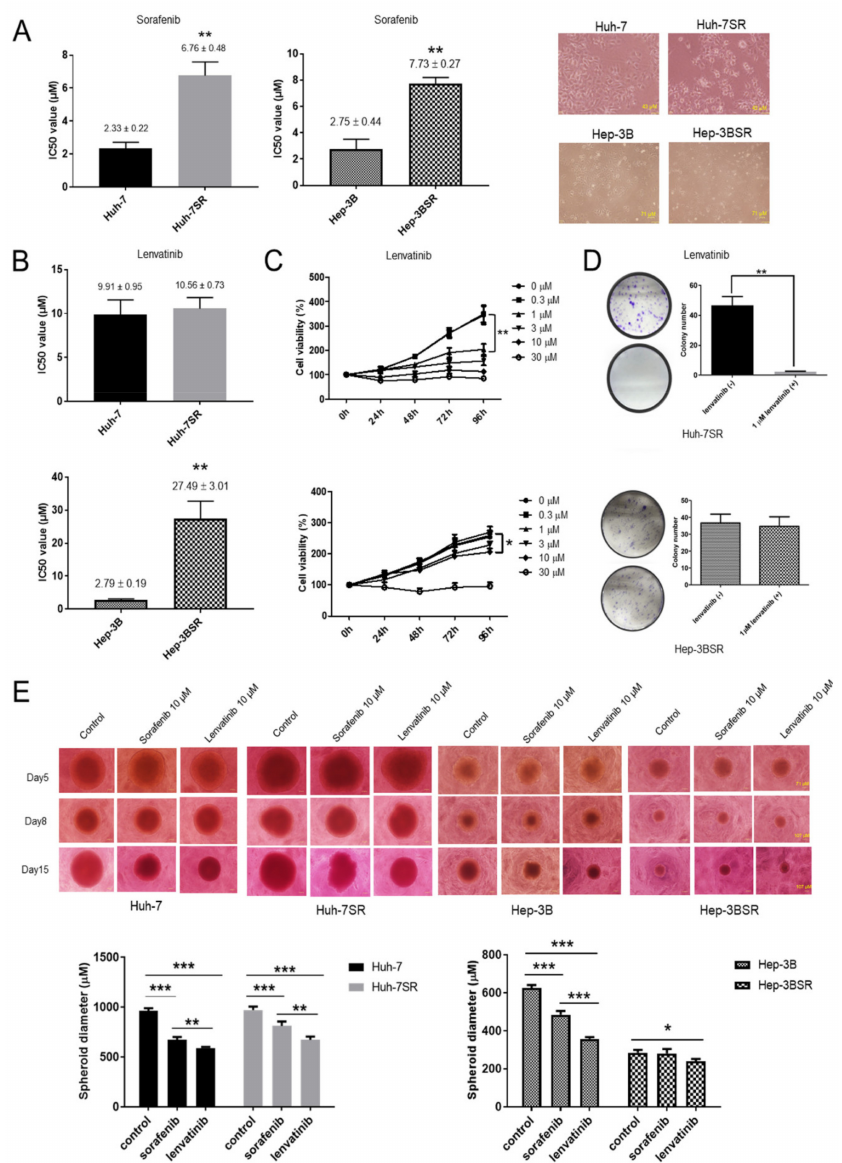
Figure 1. Lenvatinib inhibits the proliferation of sorafenib-resistant human hepatocellular carcinoma (HCC) cells. ( A ) Cytotoxic effect of sorafenib (IC 50 ): Cells were treated for 48 h with increasing concentrations of sorafenib, and dimethyl sulfoxide (DMSO) was used as a negative control. IC 50 of Huh-7 sorafenib-resistant (Huh-7SR) cells was 2.9-fold that of Huh-7 cells, and IC 50 of Hep-3BSR cells was 2.81-fold that of Hep-3B cells. ( B ) Cytotoxic effect of lenvatinib (IC 50 ): Cells were treated for 48 h with increasing concentrations of lenvatinib, and dimethyl sulfoxide (DMSO) was used as a negative control. Lenvatinib IC 50 values of Huh-7 and Huh-7SR cells were not significantly different. Lenvatinib IC 50 of Hep-3B sorafenib-resistant (Hep-3BSR) cells was 9.85-fold that of Hep-3B cells. ( C ) Anti-proliferative effect of lenvatinib measured using cell viability assay: Huh-7SR and Hep-3BSR cells were treated for 96 h with the indicated concentrations of lenvatinib or DMSO. The relative cell number was normalized with the control. ( D ) After 1 µ M lenvatinib or DMSO treatment, the colonies formed were fixed and stained with crystal violet. ( E ) Three-dimensional tumor spheroid assay was performed to evaluate the effect of lenvatinib and sorafenib on the wild-type and sorafenib-resistant HCC cell proliferative ability. The representative images of spheroids are shown (scale bar: 5th day, 71 µ m; 8th and 15th days, 107 µ m). Spheroid diameters were measured on 15th day. Data are represented as means ± standard error of mean (SEM) or means ± standard deviation (SD) of at least three independent experiments. * p < 0.05, ** p < 0.01, *** p <